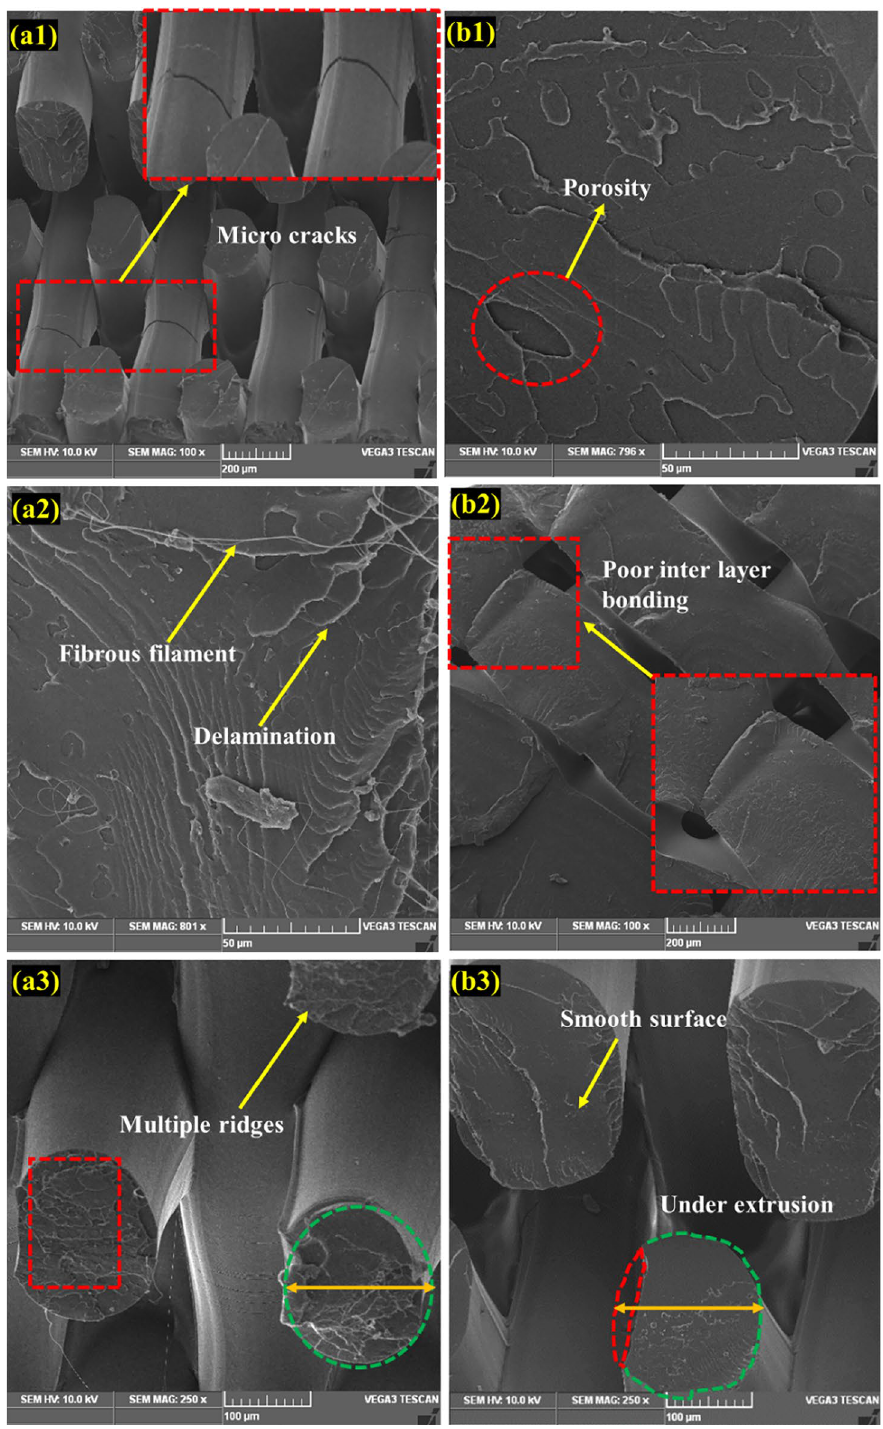
Figure 8. Comparison of fracture mechanism of tensile specimens ( a 1– a 3) optimum parameters (Layer thickness = 0.1 mm, Printing speed = 58 mm/s, Printing temperature = 199 °C), ( b 1– b 3) non-optimum parameters (Layer thickness = 0.2 mm, Printing speed = 70 mm/s, Printing temperature = 195